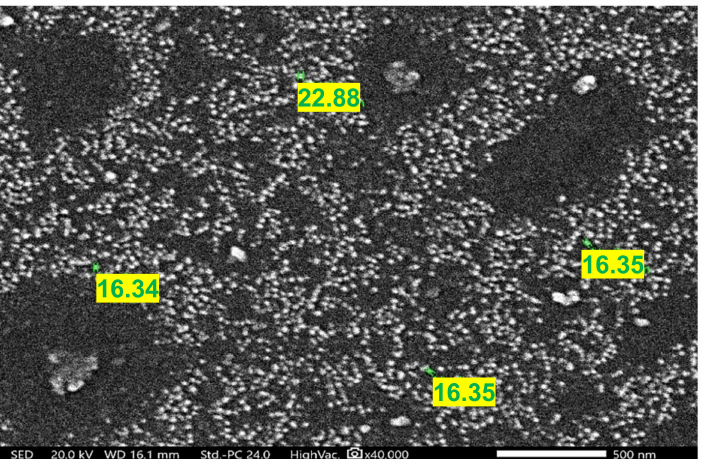
Figure 1. SEM image of iron oxide nanoparticles (IONPs). IONPs were spherical in shape with an average size of 16.34–22.88 nm. The scale bar represents 500